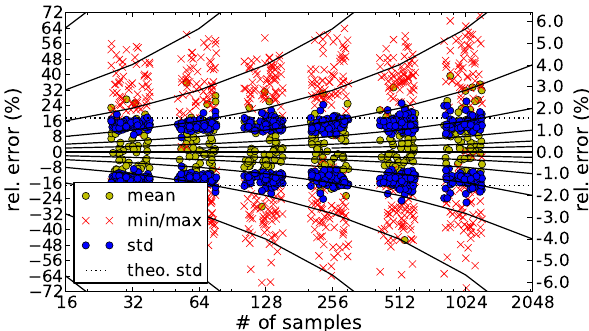
Fig. 1. Accuracy for estimation of errors for varying samples sizes. Shown are the means of the relative error of the standard devia- tion estimate (yellow circles), the real standard deviation of the es- timates generated by comparison of the estimates with determin- istically calculated errors (blue circles) and minimal and maximal relative errors (red crosses). The dotted horizontal line is the theo- retical standard deviation of the standard deviation estimate. Please note the varying vertical scale with solid lines indicating identical relative errors. The samples sizes are always powers of